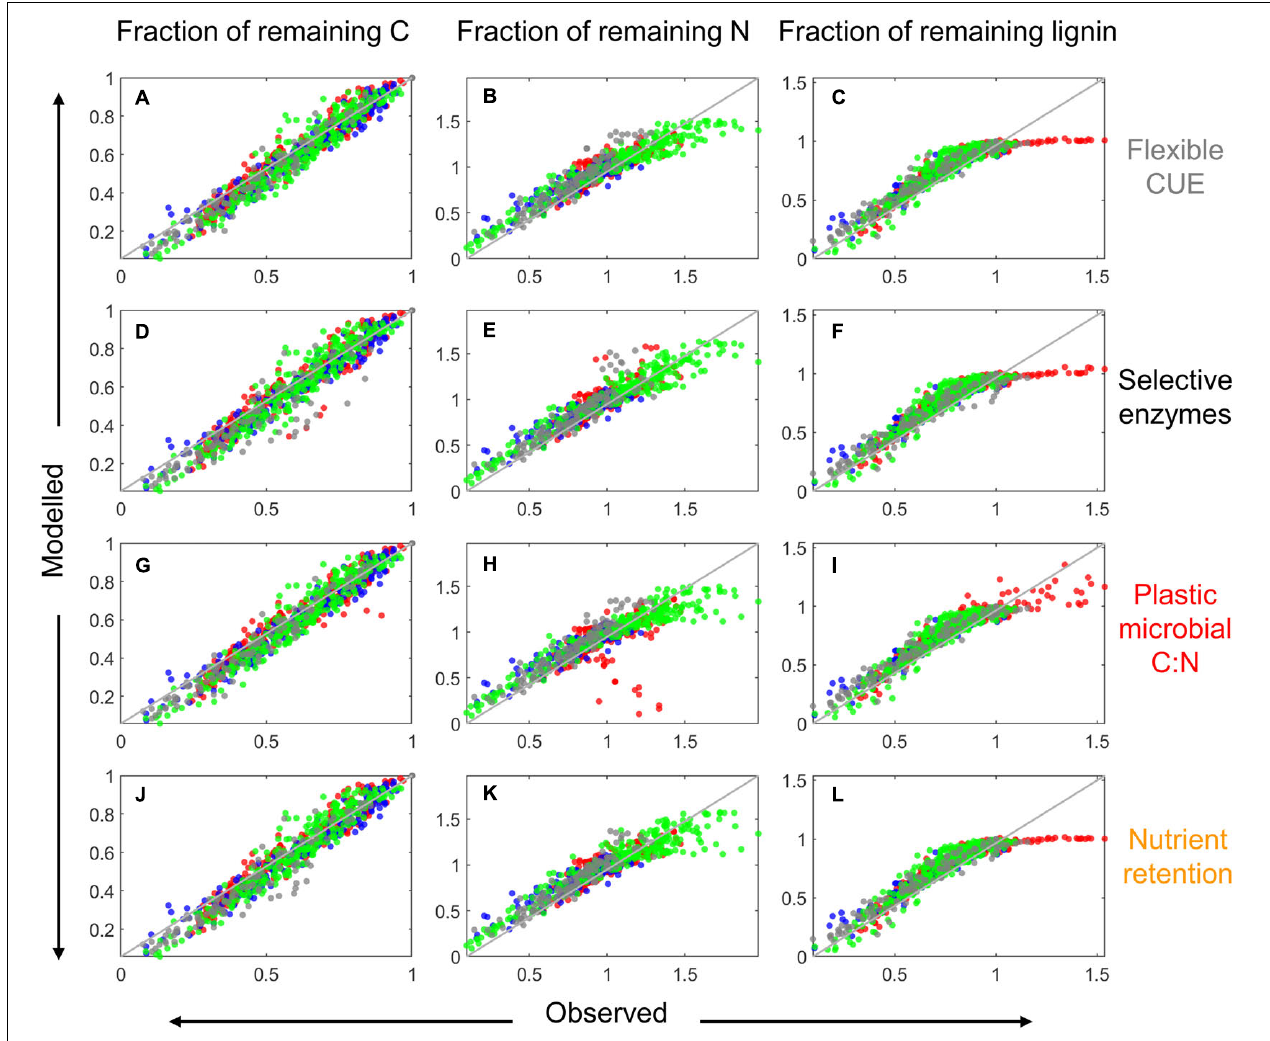
FIGURE 7 | Comparison of modeled and observed fractions of remaining total C [left column: (A,D,G,J) ], total N [center column: (B,E,H,K) ], and lignin ( C O ) [right column: (C,F,I,L) ] for the four resource use modes (as indicated on the right) when the model parameters were locally fitted. Data points are color coded according to their source: red from Berg and McClaugherty (1989), green from Osono and Takeda (2004, 2005), gray from Osono (2017), and blue from Hirobe et al. (2004); the 1:1 line is depicted as a solid gray